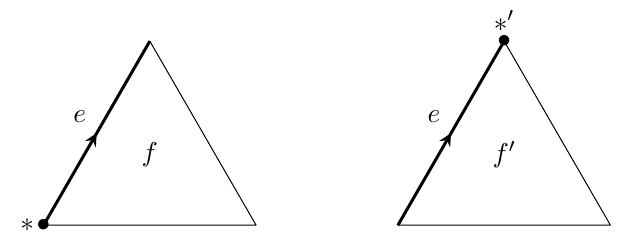
Figure 9 . Illustration of the change of a base point. In this case f 0 = e B f